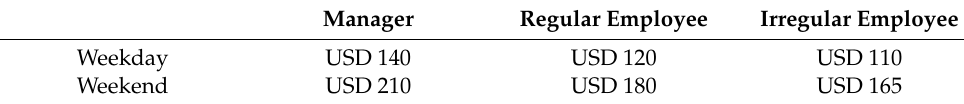
Table 4. Costs for all employees during daytime (unit: USD/day).